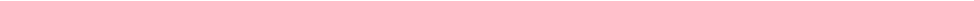
Figure 7. Summarization of a NewsRoom test sample.